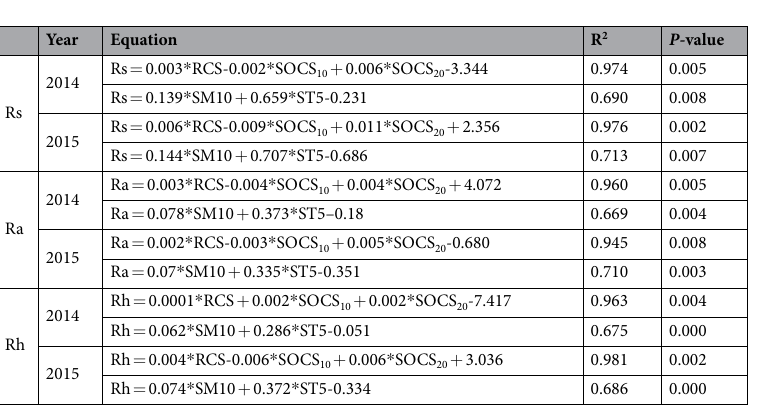
Figure 7. The relationships between soil respiration (Rs); autotrophic respiration (Ra); heterotrophic respiration (Rh) and soil temperature and volumetric soil moisture.